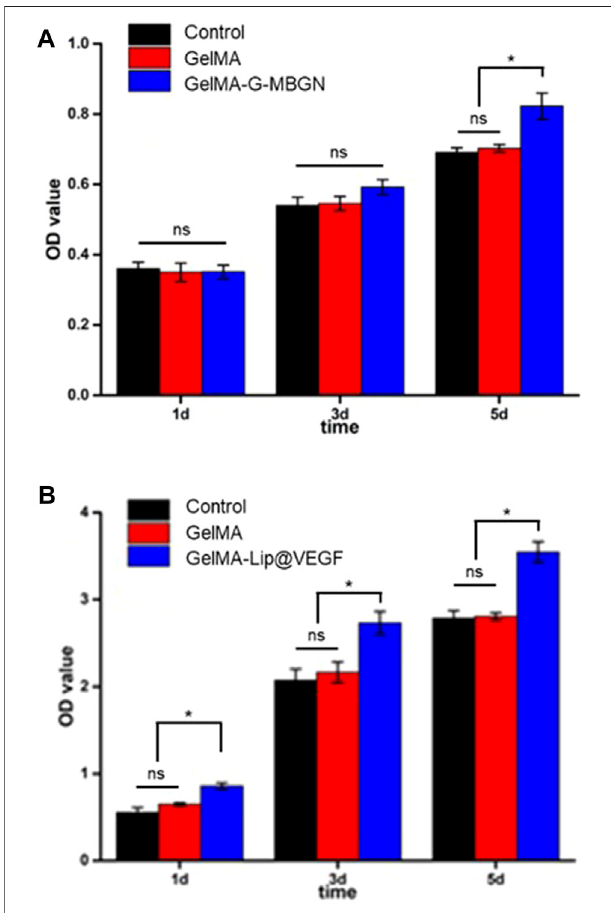
FIGURE 6 | Characterization of the proliferation rate. (A) CCK-8 test for BMSCsseededontheGelMA-G-MBGNhydrogel. (B) CCK-8testforBMSCs seeded on the GelMA-Lip@VEGF